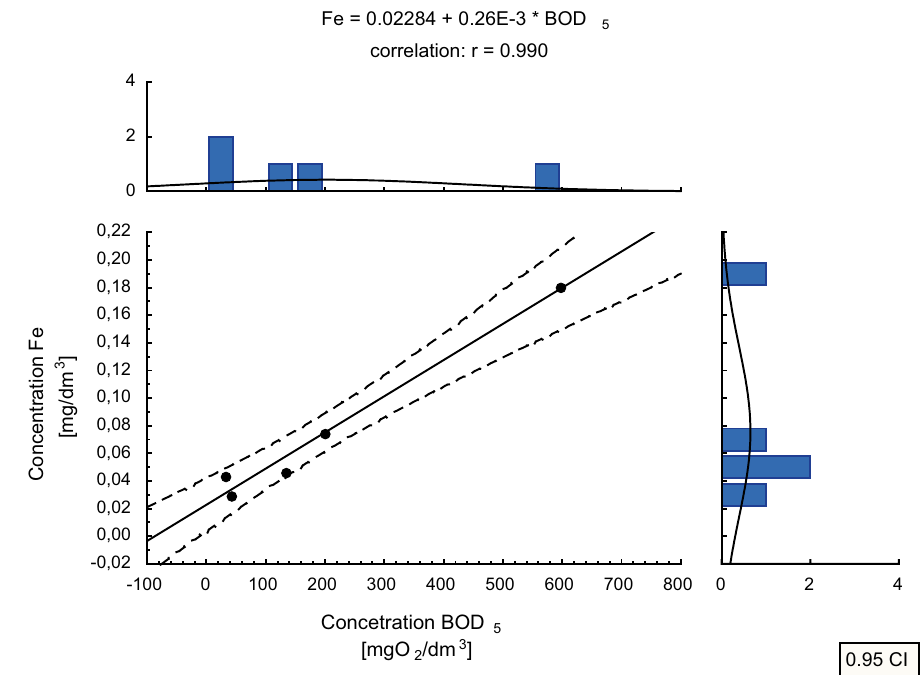
Fe = 0.02284 + 0.26E-3 * BOD 5 correlation: r =